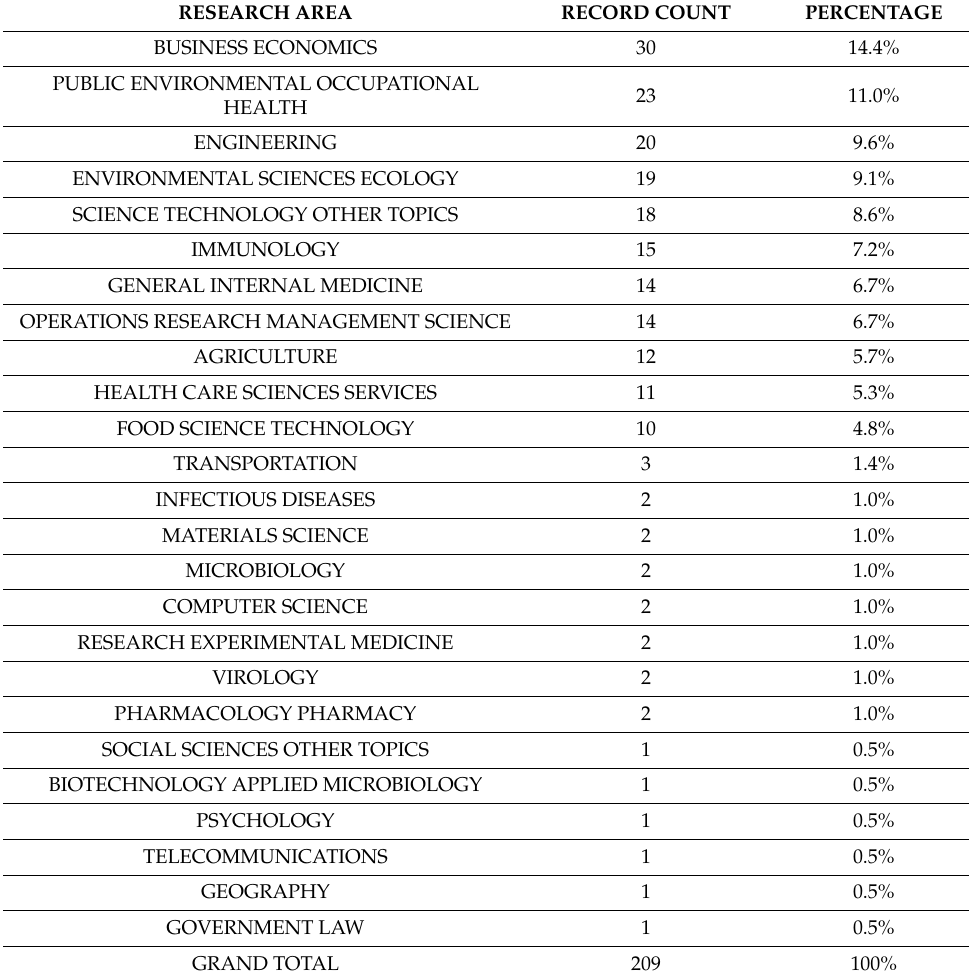
Table 4. Research Articles by Research